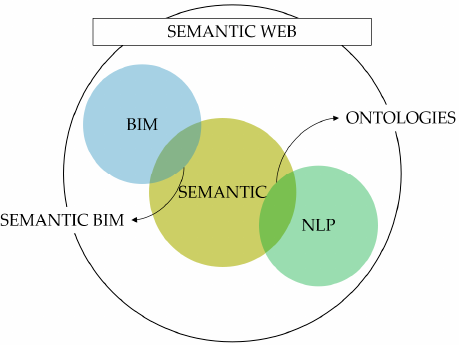
Figure 7. Semantic Web topic, it includes the sub-topics BIM, NLP, and Semantic.